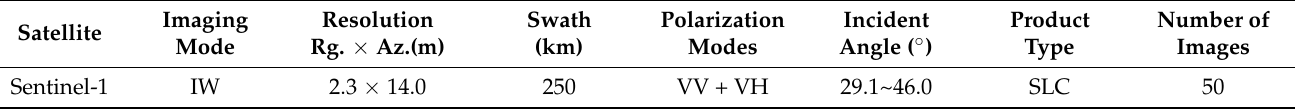
Table 1. Detailed information for the original Sentinel-1 imagery.